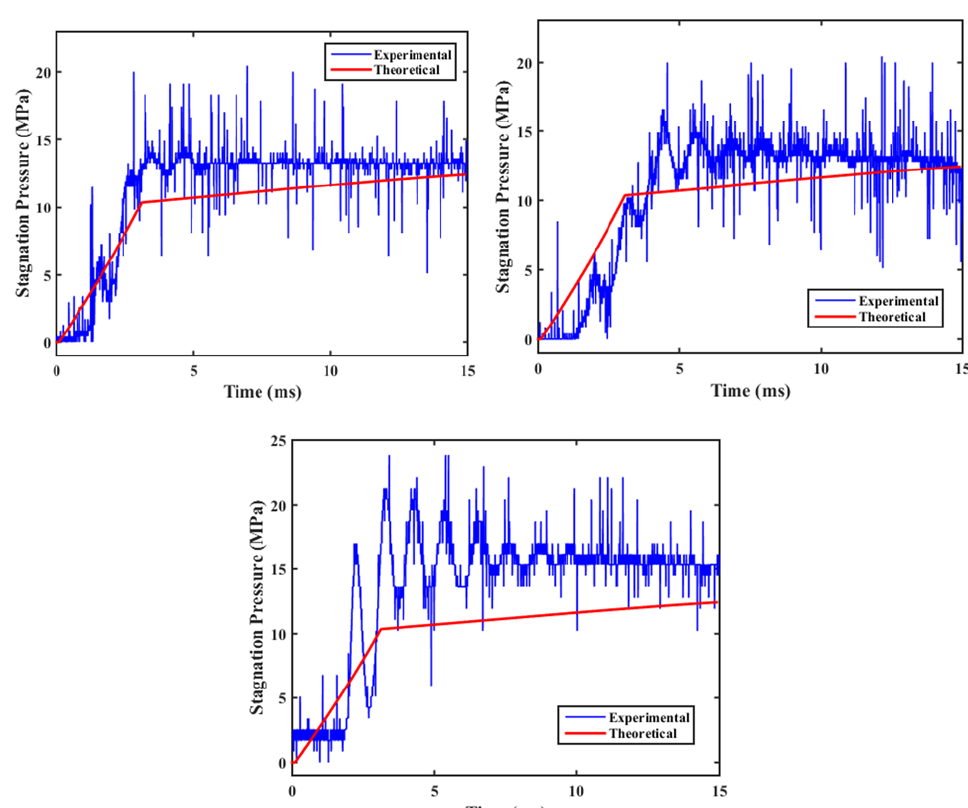
Figure 9. Test trials illustrating repeatability of servo-tube injector in shaping pressure pulse.